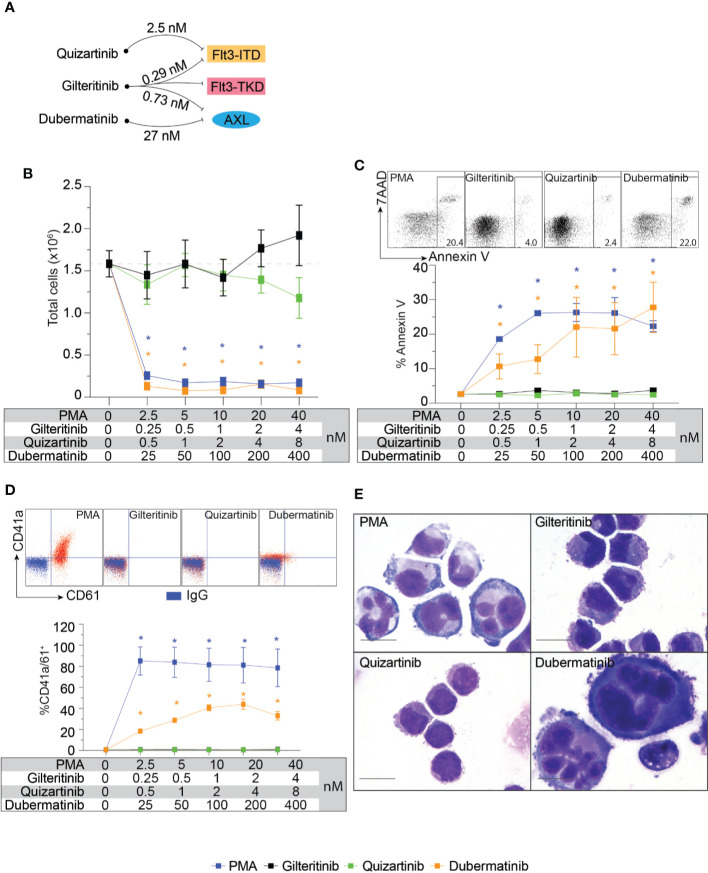
Biological effects of Flt3 and AXL inhibitors on cell proliferation, megakaryocytic differentiation, and apoptosis in K562. (A) Schematic diagram showing targets of drug action and approximate 50% inhibitory concentration for each target. (B) Cell proliferation assay showing total live cells following 72-h treatment with indicating condition in the table. Results from three independent experiments are shown as mean ± SD. * indicates significance compared with untreated (dash line). (C) Flow cytometric analysis of Annexin V and 7AAD following 48-h treatment with indicating condition in the table. Representative dot plots and a gating threshold are shown. Results from three independent experiments are shown as mean ± SD. * indicates significance compared with untreated. (D) Flow cytometric analysis of CD41a and CD61 following 72-h treatment with indicating condition in the table. Representative dot plots are shown; isotype controls are shown in blue and the treated cells are shown in red. Results from three independent experiments are shown as mean ± SD. * indicates significance compared with untreated. (E) Wright-Giemsa stain of K562 cells after treatment with indicated inhibitors for 72 h.